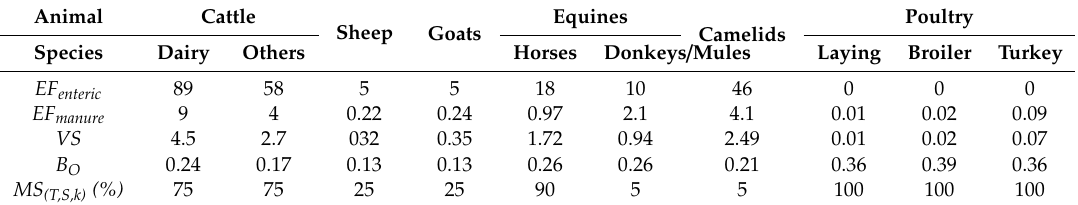
Table 1. Emission factors corresponding to methane (kg CH 4 .head − 1 .year − 1 ) issued from